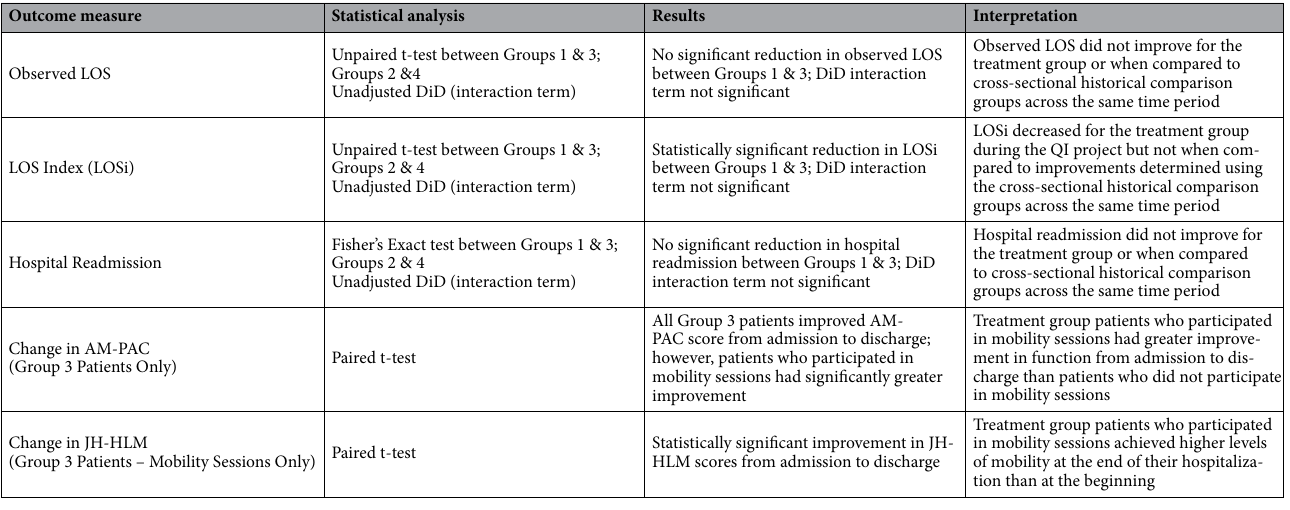
Table 6. Summary of